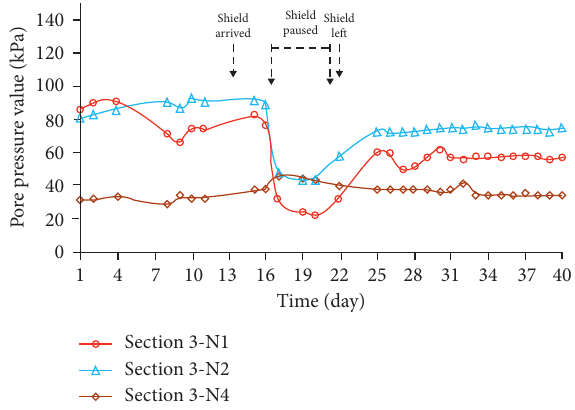
Figure 7: Variation curves of pore pressure for the cross section in Section